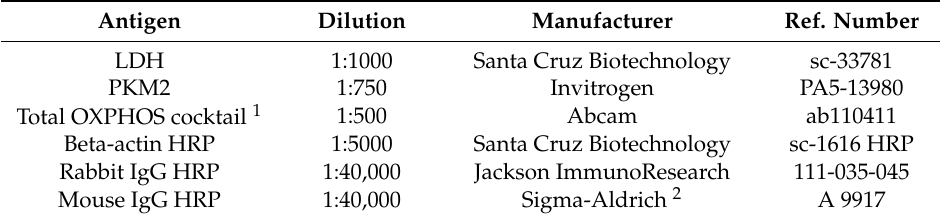
Table 1. Antibodies and dilutions used for Western